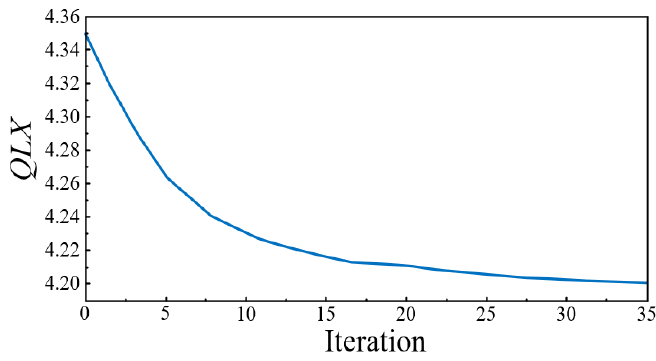
Figure 17. Iterative process of BIW lightweight coefficient.